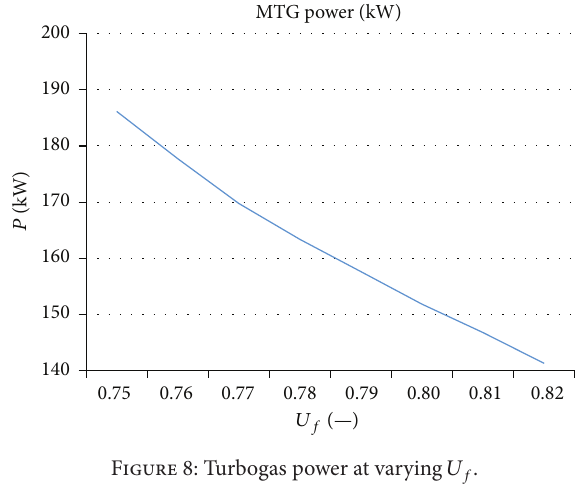
Figure 6: Percentage of prereforming at varying 𝑈 𝑓 .